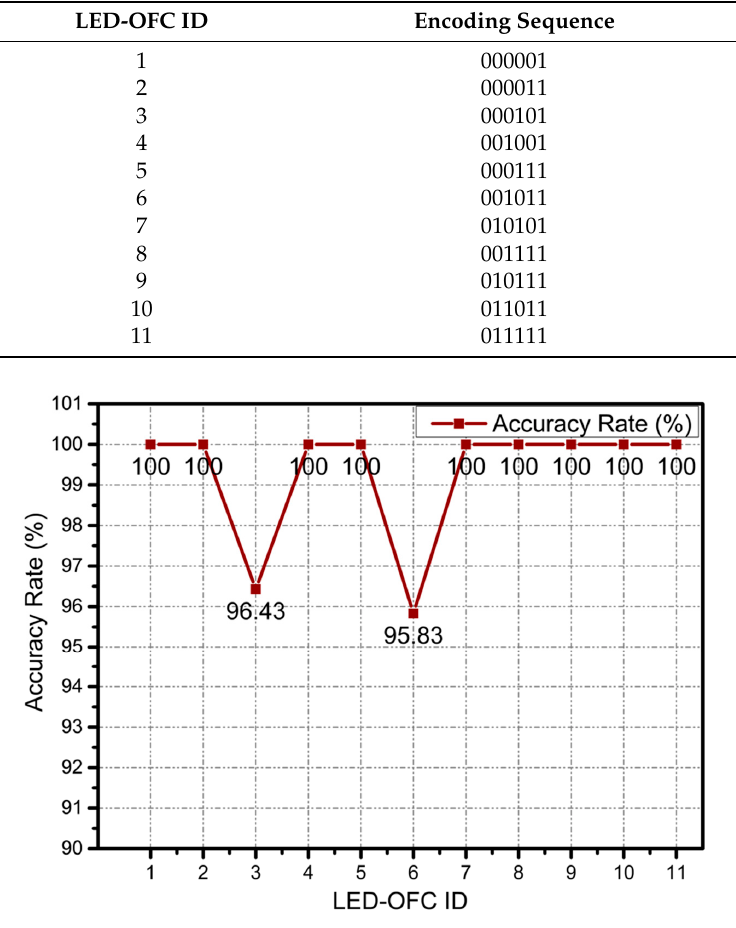
Figure 13. Recognition accuracy of different encoding sequences.